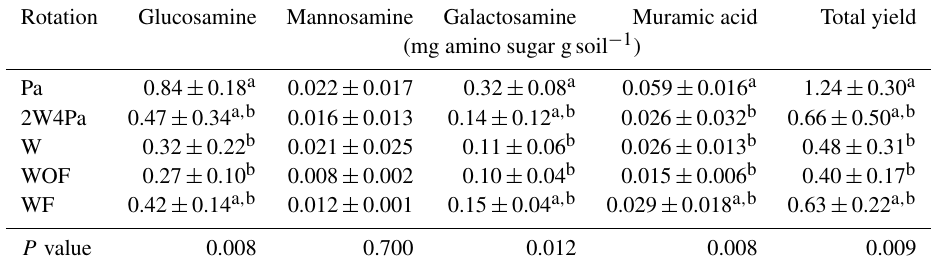
Table 3. Amino sugar data (mean ± 1SD reported). One-way repeated-measures ANOVA summary given below each data column and pairwise comparisons between rotations are indicated with different letters in each column when significant ( α< 0 . 05).